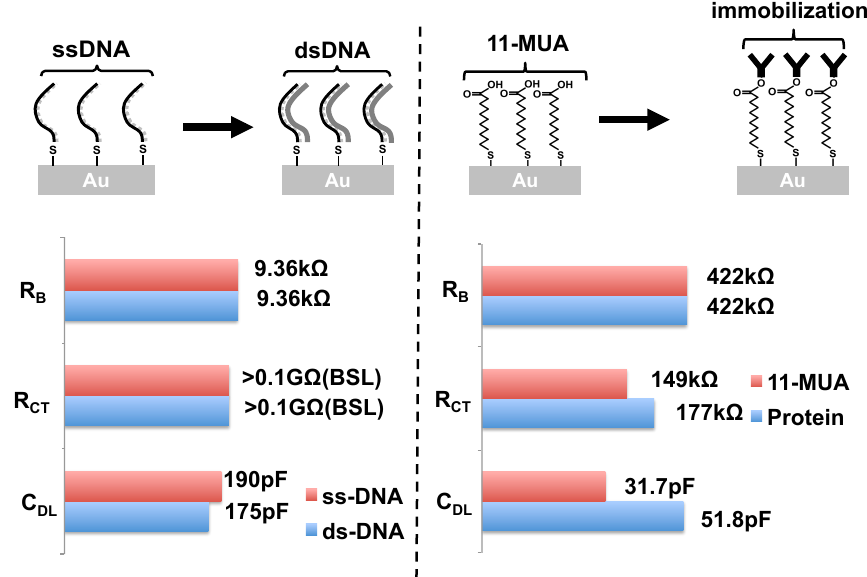
Figure 16. Equivalent circuit parameters for DNA hybridization experiment ( left ) and protein attachment detection ( right ). The experiments were done using on-chip electrodes. BSL refers to the beyond sensitivity